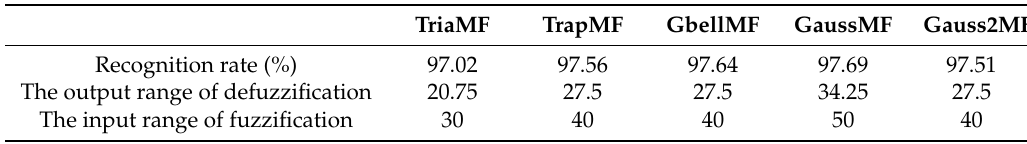
Table 2. Optimal recognition rates for different membership functions.